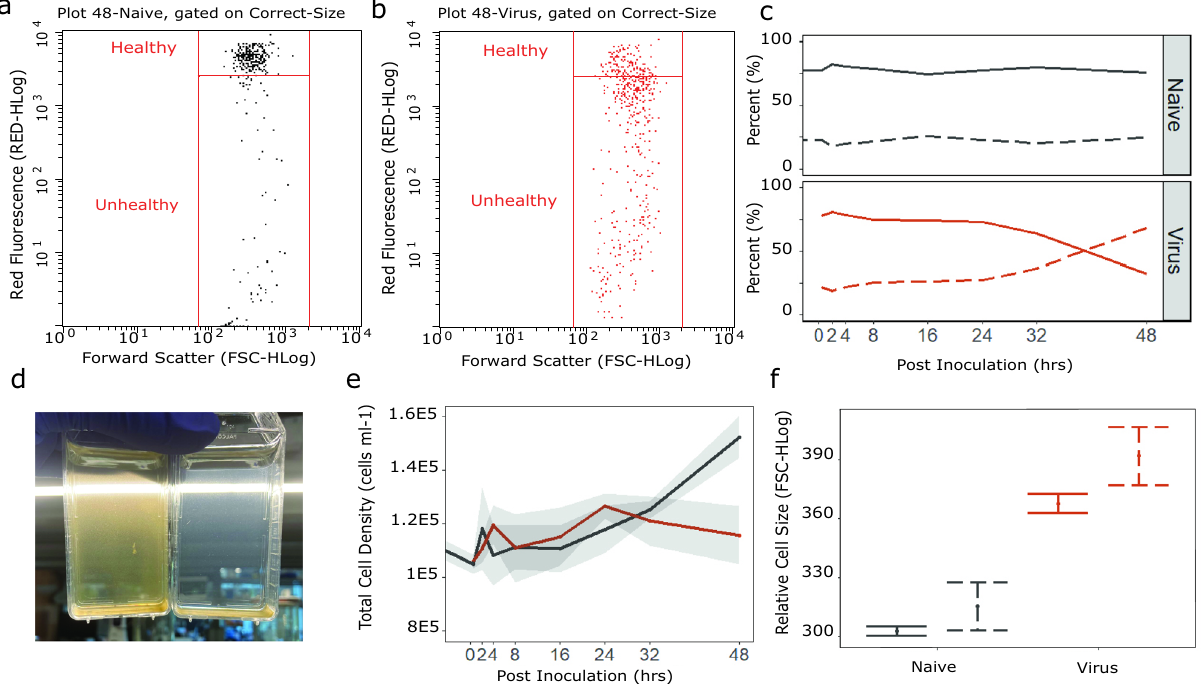
Figure 1. Culture dynamics of Heterocapsa circularisquama cells inoculated with HcRNAV strain A-2. Cultures include two sub- populations: a healthy population characterized by high red-autofluorescence, and cells declining in health as indicated by decreased red-autofluorescence. Flow cytometry dot plots depict naive ( a ) and viral-exposed ( b ) cultures containing different proportions of healthy and unhealthy sub-populations at 48 h post-inoculation. ( c ) Cultures are normally dominated by healthy cell populations (solid line) but shift to being dominated by the unhealthy population (dashed line) over the course of viral-infection. ( d ) Side-by- side comparison of naïve (left) and viral-exposed (right) cultures 48 h post-inoculation indicated clearing of cultures, presumably due to a loss of motility. ( e ) Despite the shift from healthy to unhealthy cell populations, there is no decrease in the overall number of viral-exposed cells (red) that would signify viral-mediated lysis. Black line = naïve cultures, shaded area = 95% confidence intervals. ( f ) After 48 h, inoculation treatments exhibit significantly different cell sizes (i.e., forward scattering), indicating viral-exposed cultures are likely on the verge of lysing (p ≤ 0.001, n = 3). Both the healthy (solid error bars) and unhealthy (dashed error bars) sub-populations are larger in viral-exposed cultures. Dot = Average, Error bars = 95% confidence